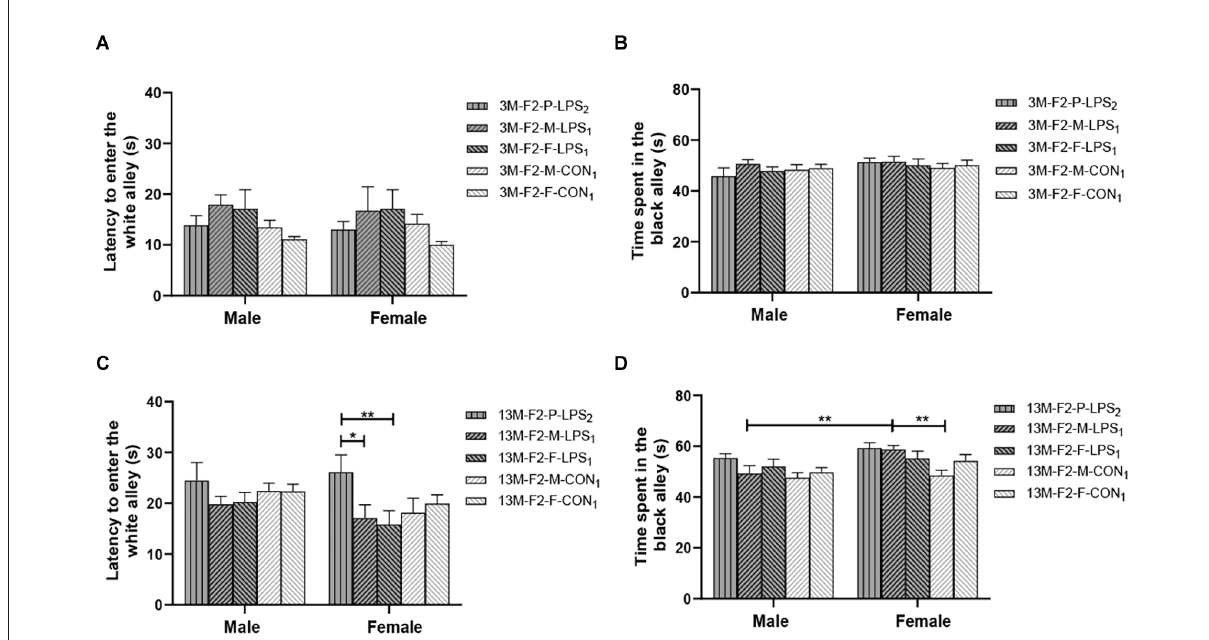
FIGURE5 Results of the black–white alley test in the F2 generation. (A,C) Latency before entering the white alley and (B,D) time spent in the black alley in the 3- (3 M) and 13-month-old (13 M) CD-1 mice in different groups. n = 10 male or female mice/group. Error bars = SEM. * P < 0.05, ** P < 0.01; F2-M-LPS 1 , mice whose mothers were exposed to prenatal inflammation; F2-P-LPS 2 , mice whose parents were exposed to prenatal inflammation; F2-F-LPS 1 , mice whose fathers were exposed to prenatal inflammation; F2-M-CON 1 , mice whose mothers were exposed to saline in utero ; F2-F-CON 1 , mice whose fathers were exposed to saline in utero .